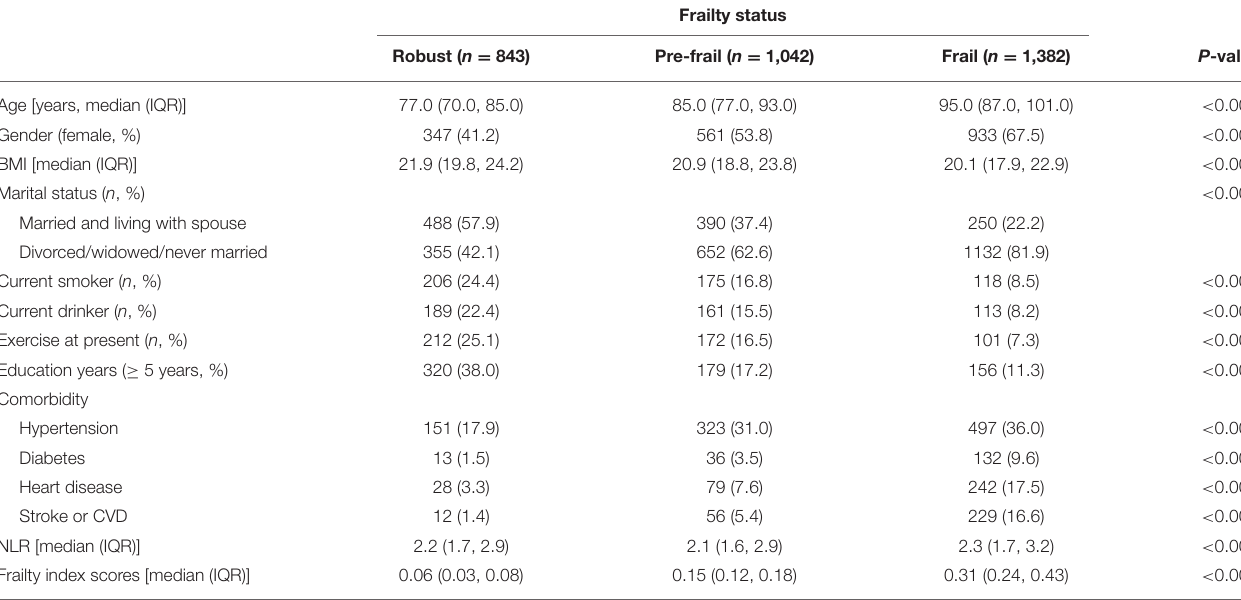
TABLE 1 | Characteristics of the community-dwelling older adults of the CLHLS ( n = 3,267, according to frailty